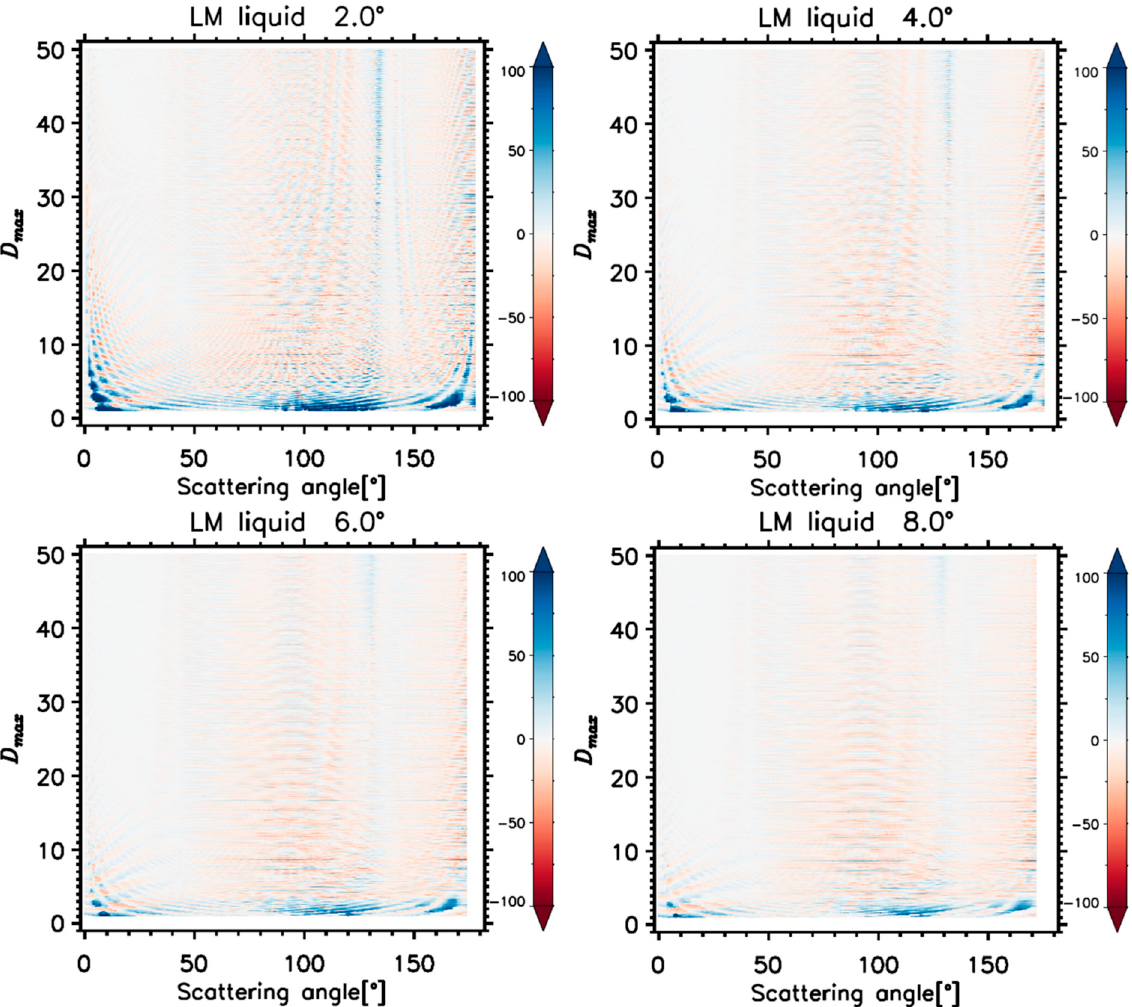
Figure 12. Determined sizing errors (%) of spherical liquid cloud droplets using a Lorenz–Mie code (LM liquid) as functions of scattering angles and the size ( D max ). Different panels indicate different resolutions (i.e., 2°, 4°, 6°, and 8°) of scattering angles.